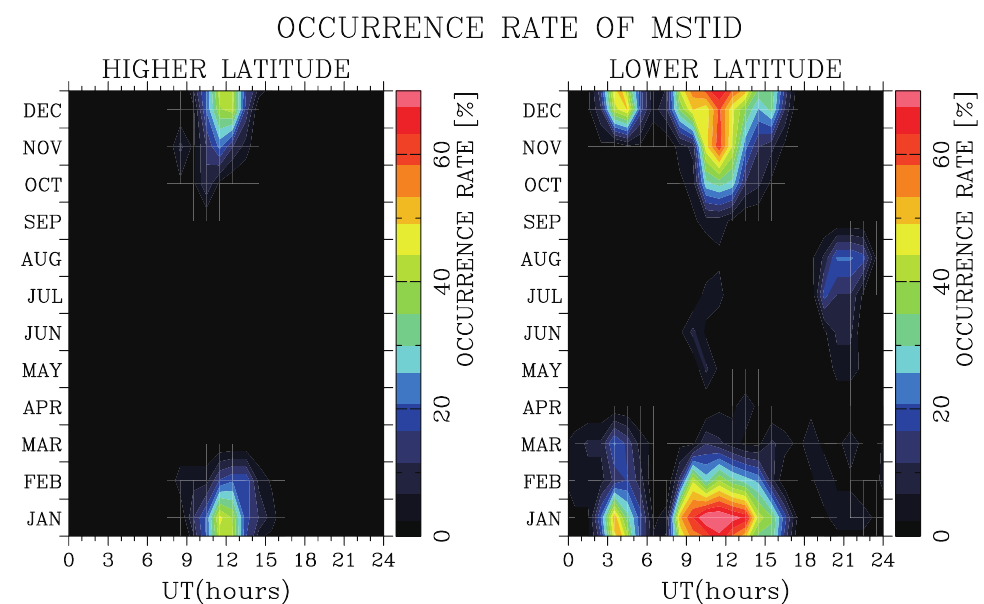
Fig. 3. Local time and seasonal variations in MSTID occurrence rate at (left) higher latitudes ( > 55 ◦ N) and (right) lower latitudes ( < 55 ◦ N) of Europe in 2008.